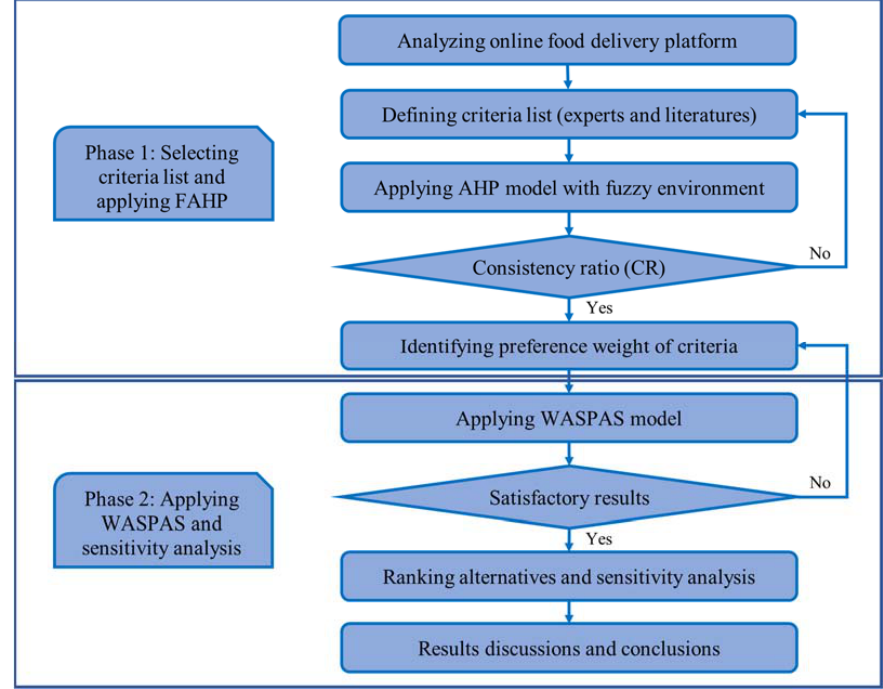
Figure 1. Research methodology for evaluation and selection OFDs. Table 2. Sustainable OFDs evaluation criteria and their description.